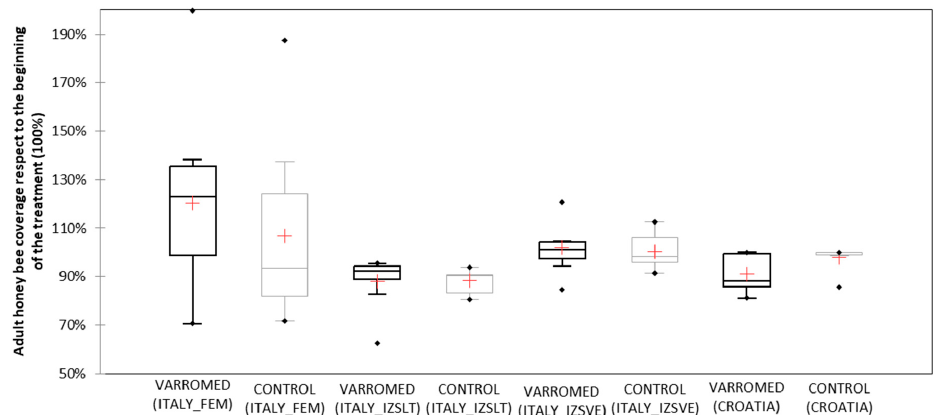
Figure 8. Boxplot of adult honey bee coverage in all groups recorded during the winter trial and compared to the beginning of the treatment (%). The horizontal line in boxes shows the median. The box shows the first and third quartile. Whiskers extend to 1.5 × interquartile range (IQR). Additionally, the pluses show mean values.